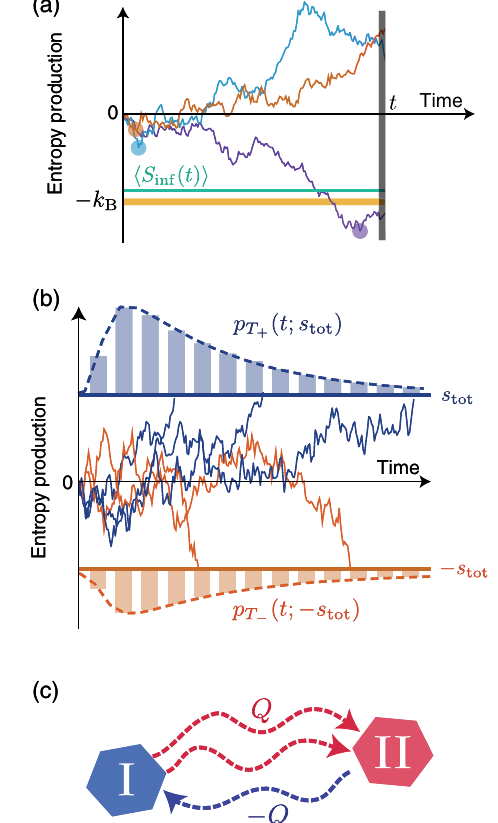
FIG. 1. Illustration of three key results of the paper. (a) Sche- matic representation of the infimum law for entropy production. Several stochastic trajectories of entropy production are shown (solid lines), and their infima are indicated (filled circles). The infimum law implies that the average infimum of the entropy production (green solid line) is larger than or equal to − k (orange B line). (b) First-passage-time fluctuation theorem for entropy production with two absorbing boundaries. We show examples of trajectories of stochastic entropy production as a function of time, which first reach the positive threshold s (horizontal thick tot blue line) and which first reach the negative threshold − s tot (horizontal thick red line). The probability distribution p T ð t ; s tot Þ þ to first reach the positive threshold at time t and the probability distribution p T ð t ; − s tot Þ to first reach the negative threshold at − time t are related by Eq. (8). (c) Waiting-time fluctuations: The statistics of the waiting times between two states I and II are the same for forward and backward trajectories that absorb or dissipate a certain amount of heat Q in isothermal